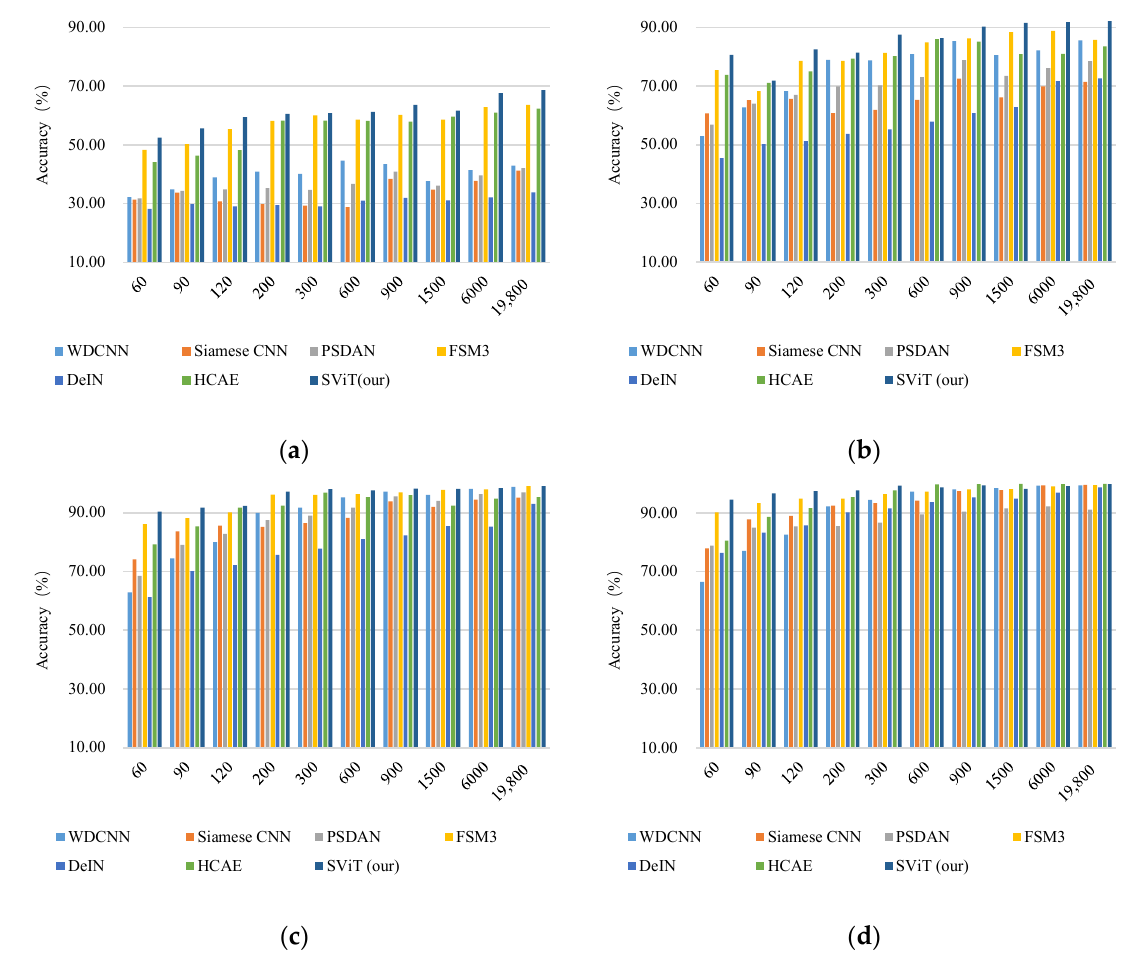
Figure 11. Results of different sample sizes in a noisy environment. ( a ) SNR = −4; ( b ) SNR = 0; ( c ) SNR = 4; ( d ) SNR = 8.